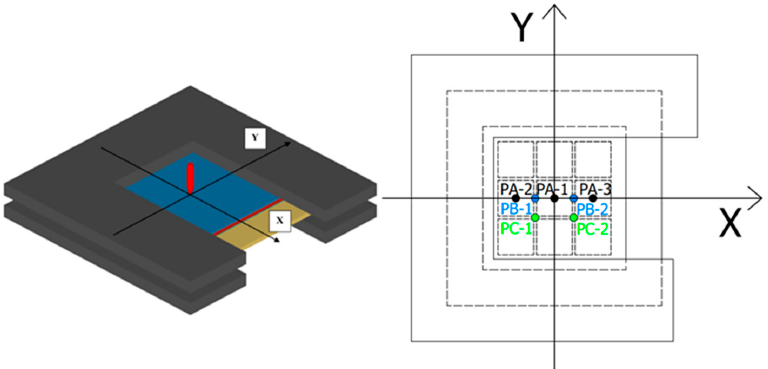
Figure 18. Finite element models of different impact positions.